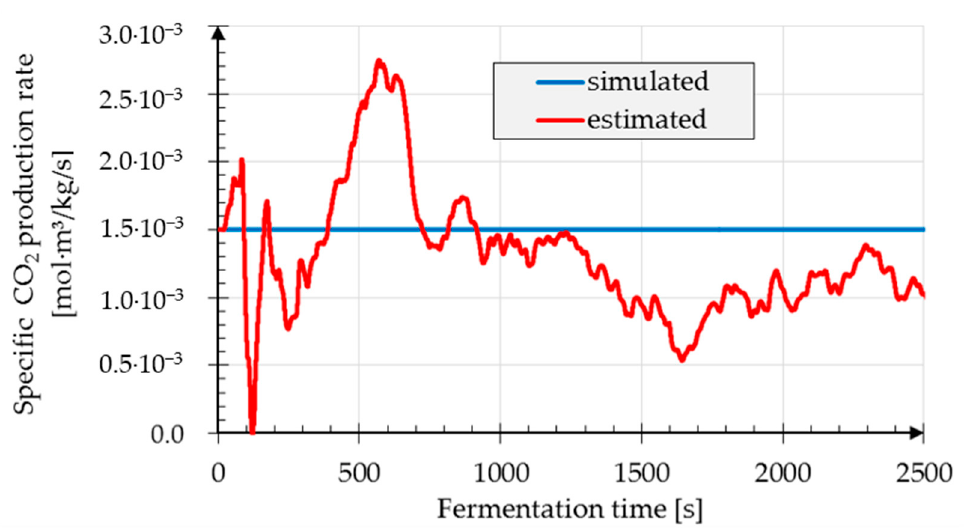
Figure 4. Simulated and Kalman estimation of the specific CO 2 production rate.